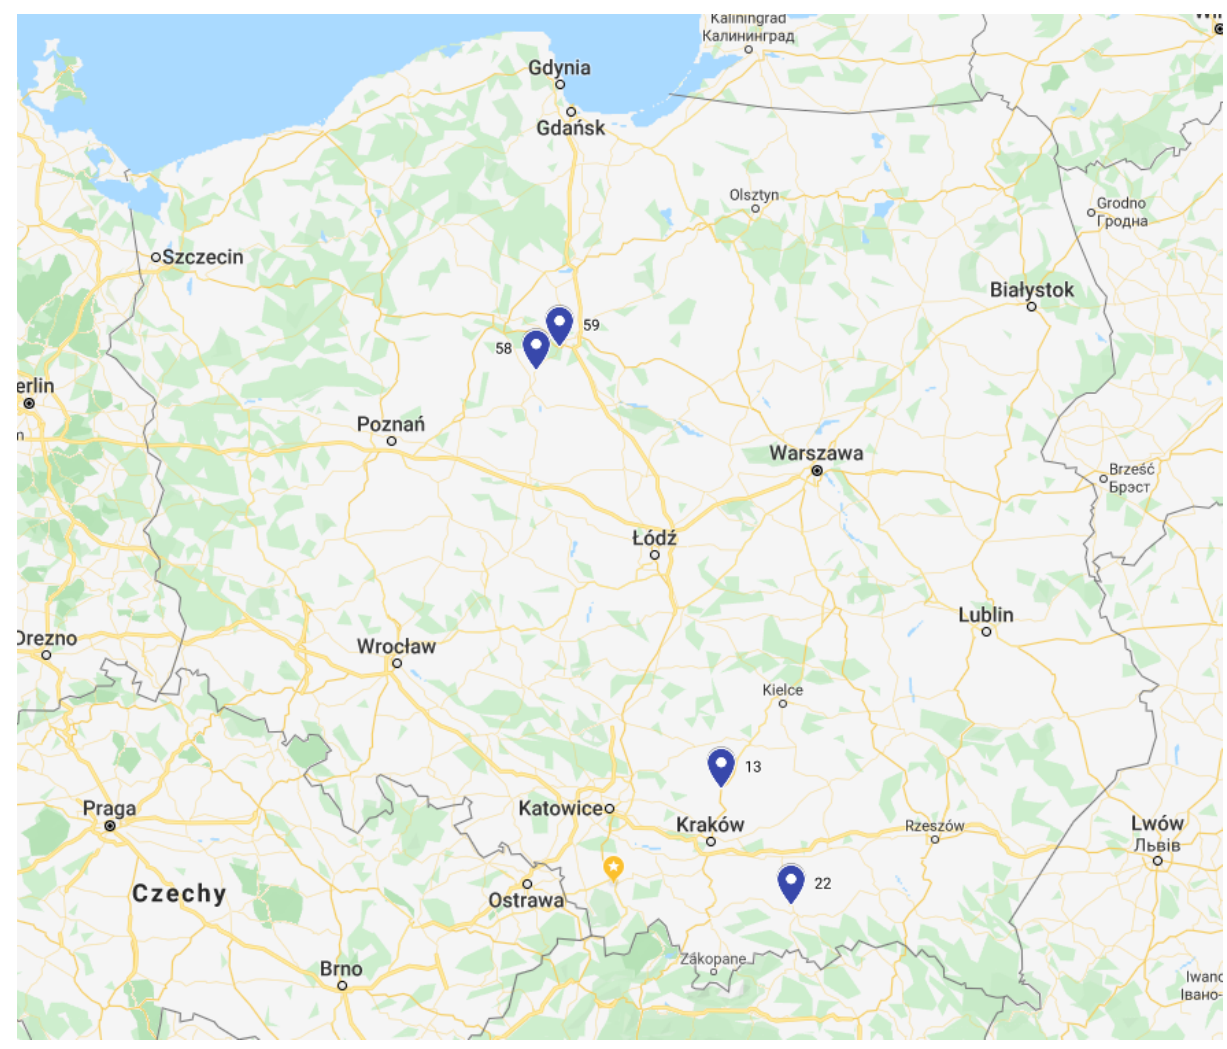
Figure 1: Location of HS-WIM station on the map of national roads (map source: Google Maps)